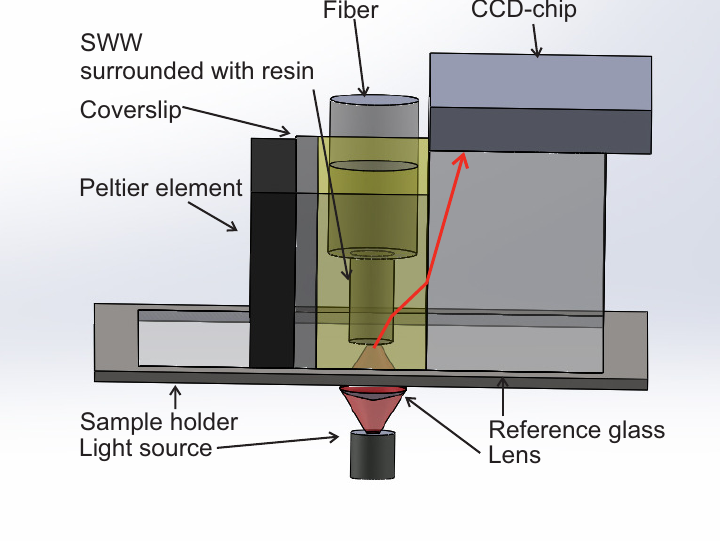
Figure 4. Scheme of the refractive index profilometer setup. A laser beam is focused on the sample surface. The main part of the beam exits the specimen through a layer of monomer (which is immersion oil in standard cases) on the backside of the reference glass, which is parallel to the entrance surface. Changes of the beam angle which exits the reference glass caused by a change of the refractive index in the beam path are detected by a large area CCD-Chip. The refractive index profilometer delivers a resolution of ≈ 10 − 5 and a pixel-resolution of ≈ 100 nm at the employed wavelength of λ = 638